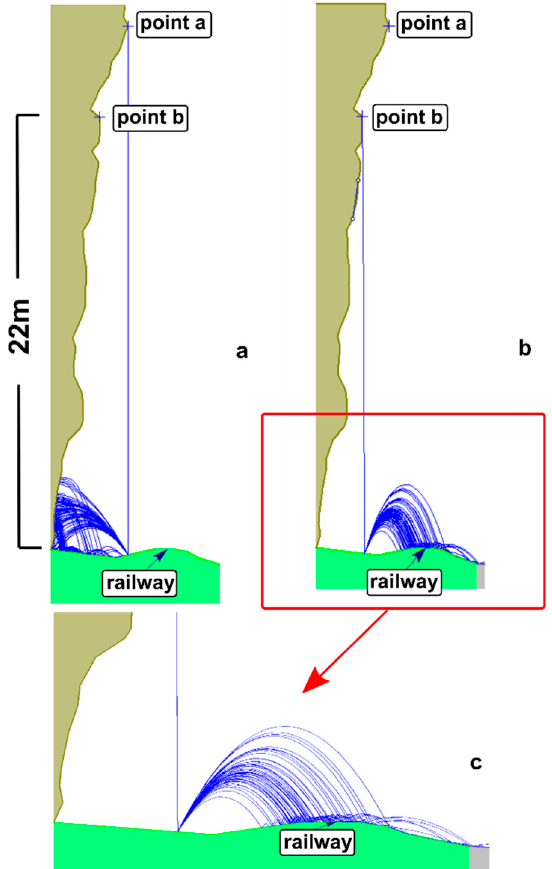
Figure 11. 2D rockfall trajectories. ( a ) profile_1, ( b ) profile_2, ( c ) focus on the lower part of rock face showing the fall track reaching the railway (profile_2). Light green color refers to the marble bedrock and green color to the debris layer. Location of source areas (seeders) are indicated by blue crosses.